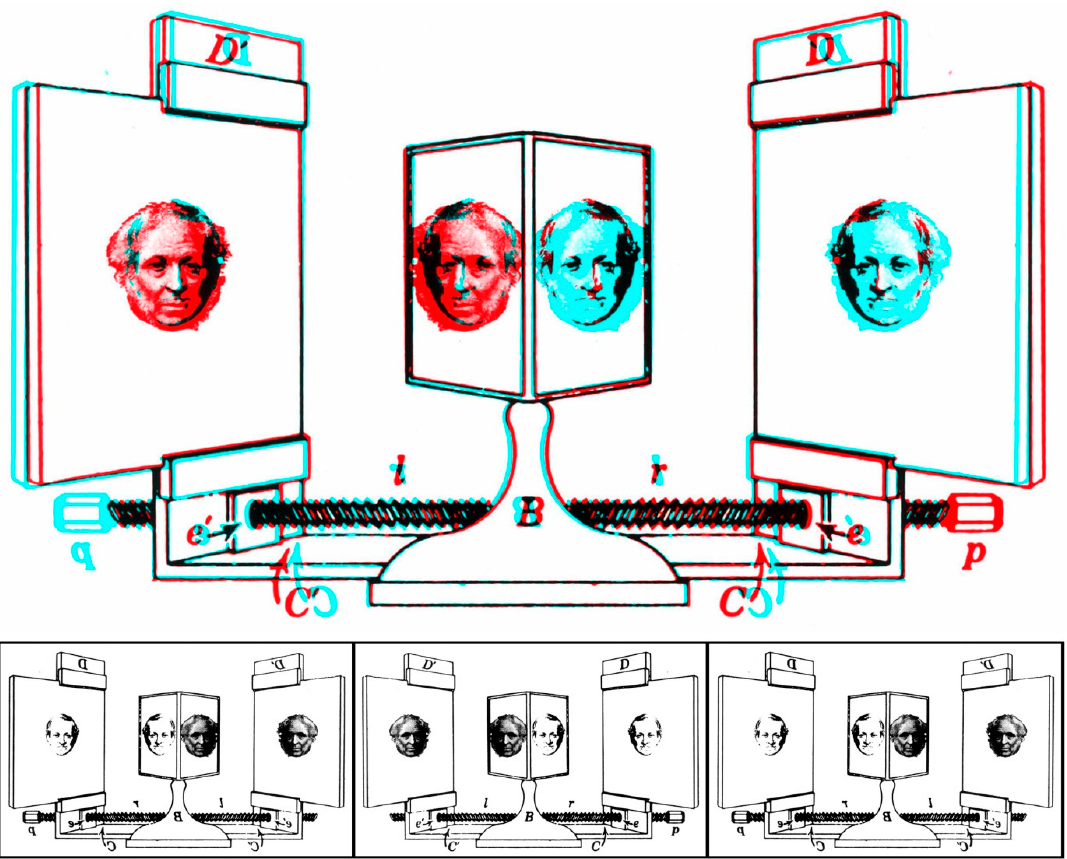
Figure 7. Ocular equivocation by Nicholas Wade. Rivalling portraits of Wheatstone and Brewster are shown mounted in Wheatstone’s stereoscope.